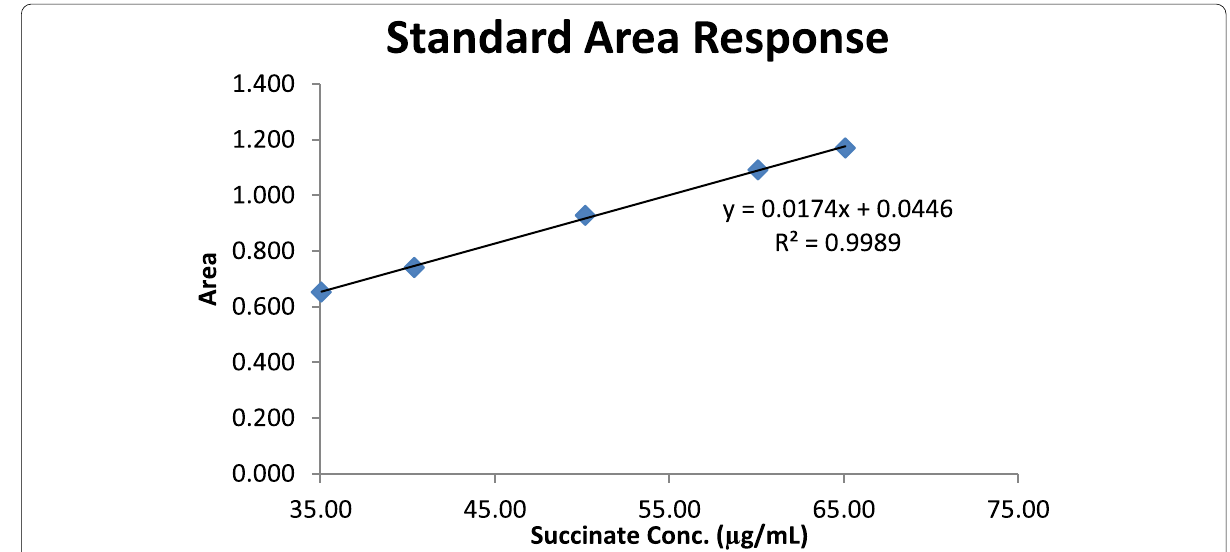
Fig. 4 Area response for working standards (35 μg/mL to 65 μg/mL range)